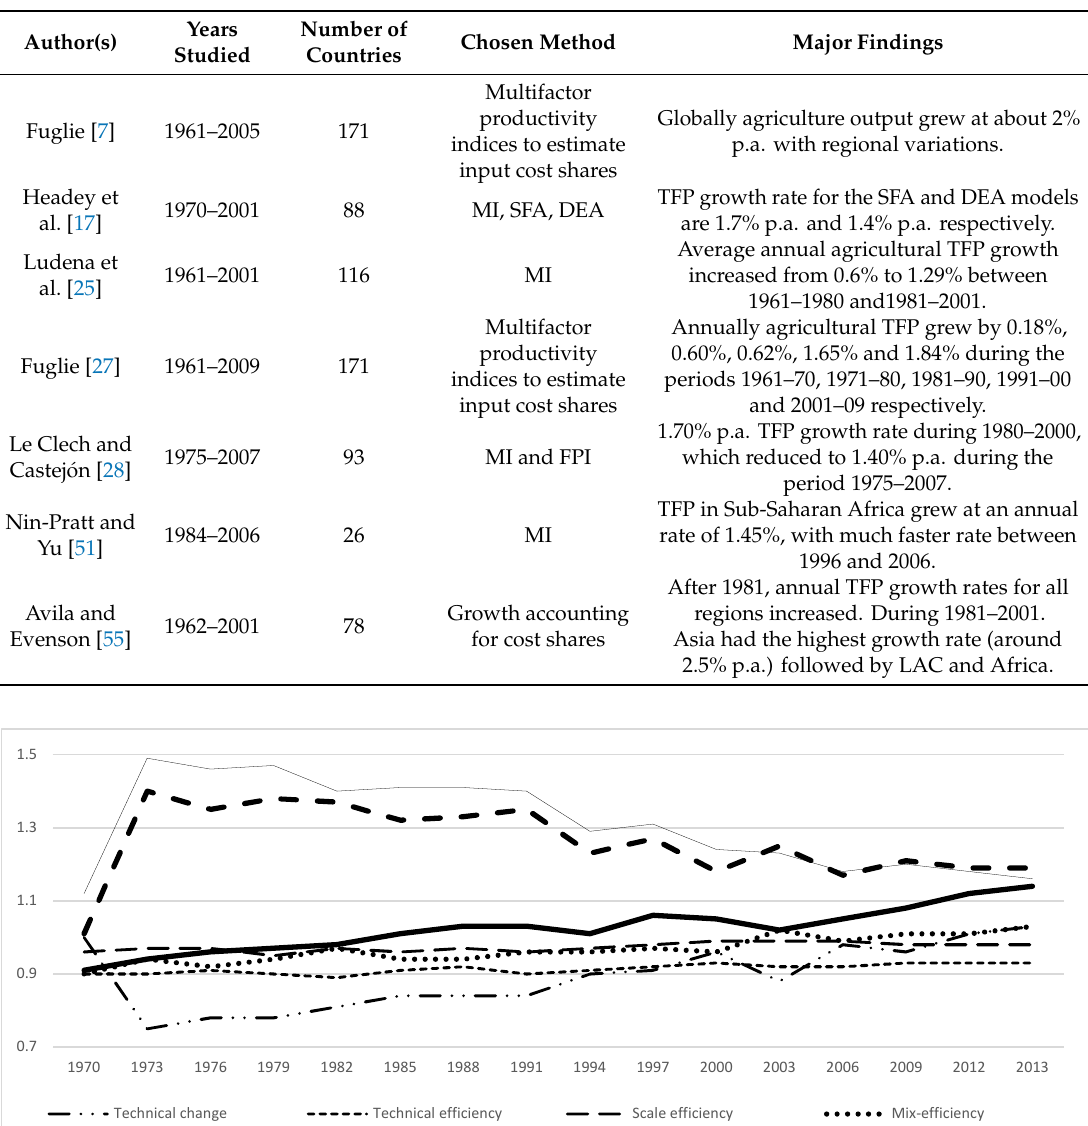
Table 3. Selected studies of total factor productivity analysis.